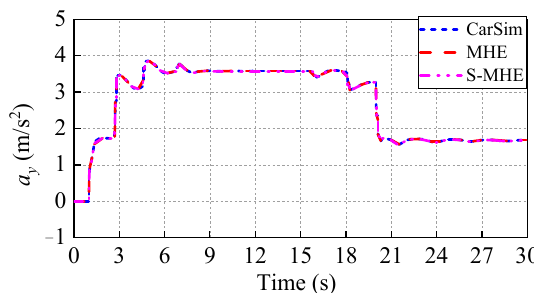
Figure 22. Lateral acceleration.